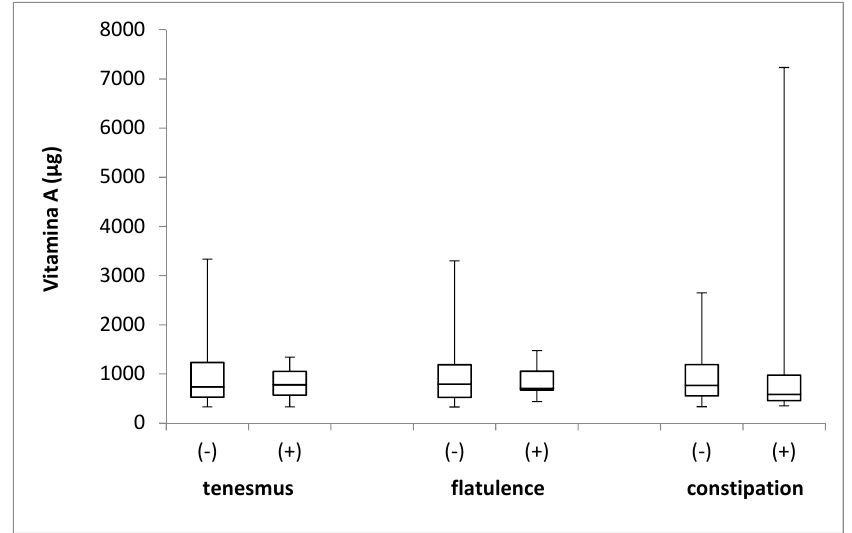
Figure 1. The box plots of vitamin A intake in groups of individuals stratified by the analyzed symptoms of tenesmus, flatulence and constipation. (-) symptom not declared; (+) symptom